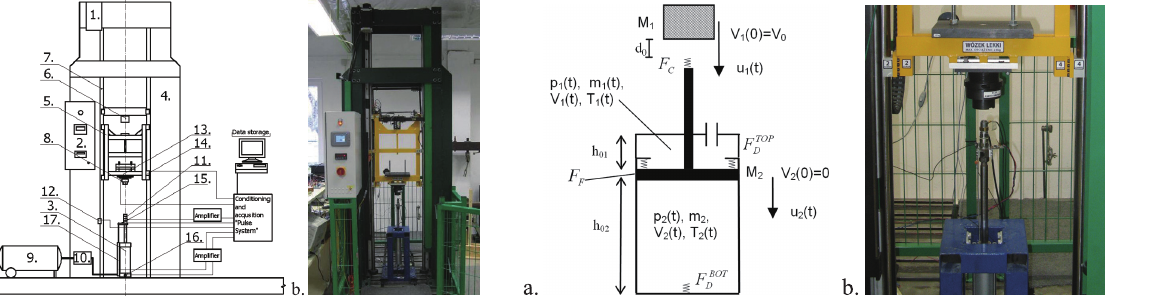
Fig. 1. Experimental free-fall drop test stand: a. schema of the set-up; b. view of the test stand.